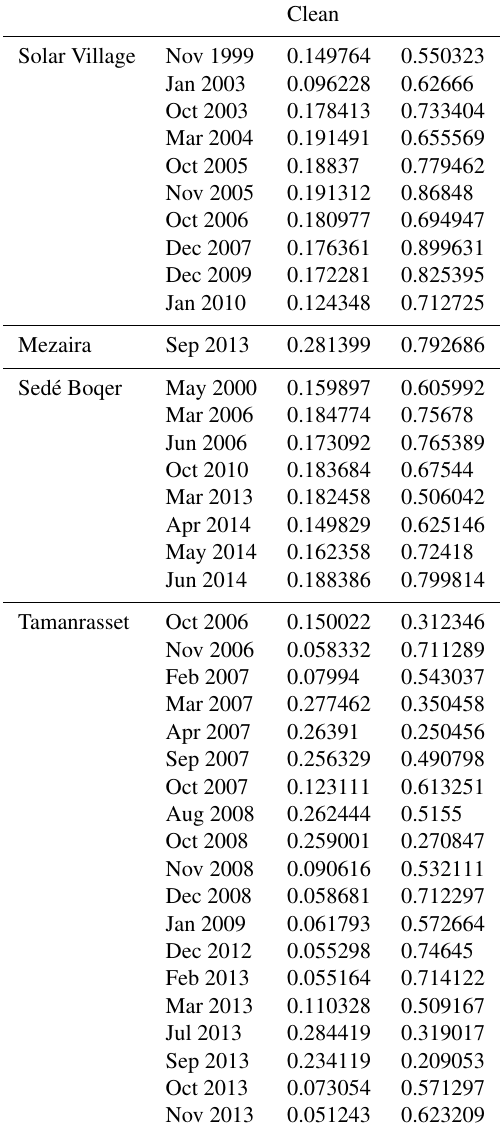
Table 6. Seasonal clear events over study locations.